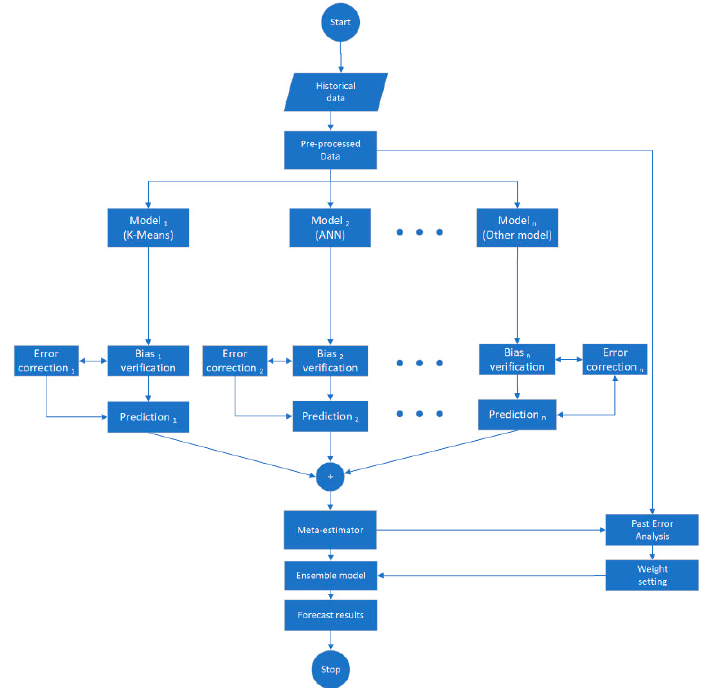
Figure 1. Demand load forecast flowchart.